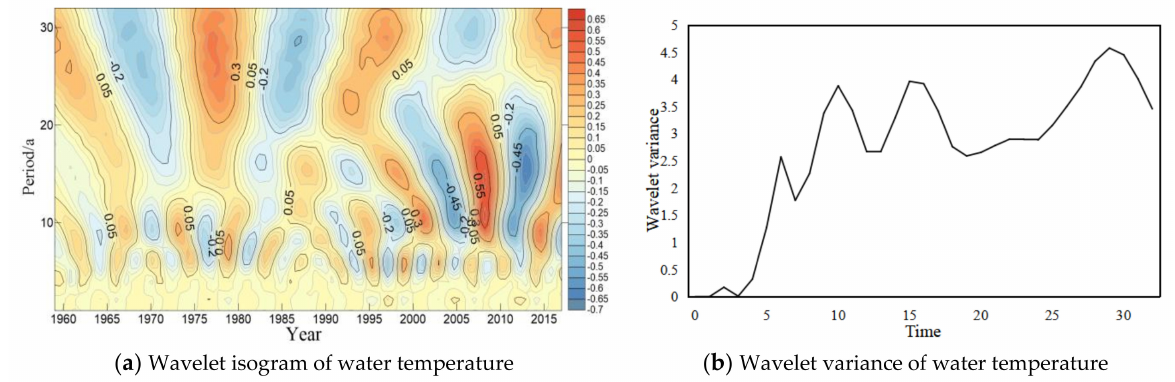
Figure 6. Wavelet isogram ( a ) and wavelet variance map ( b ) of water temperature at Hankou